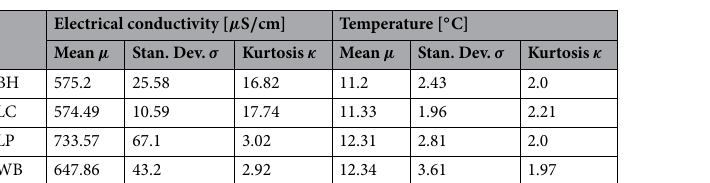
Table 1. Mean µ , standard deviation σ and kurtosis κ of electrical conductivity and temperature at all four measurement